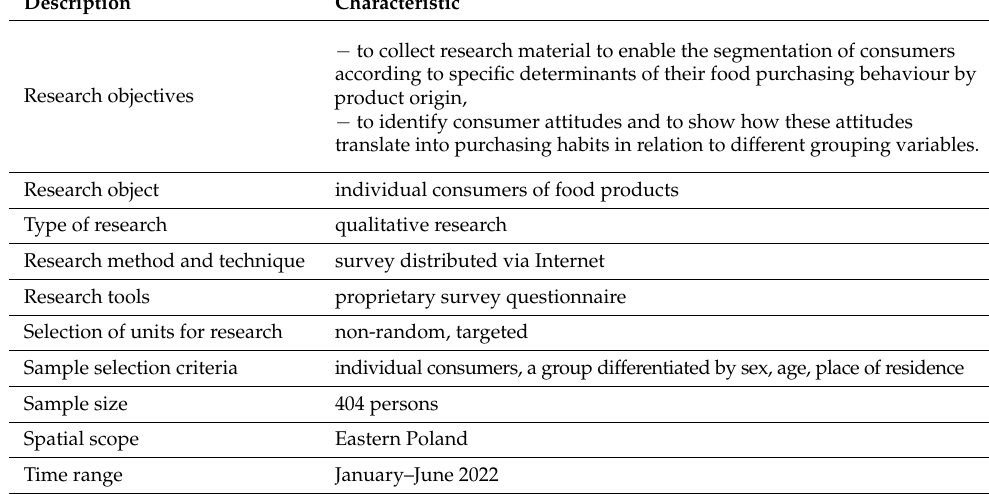
Table 1. Consumer research in Eastern Poland—basic